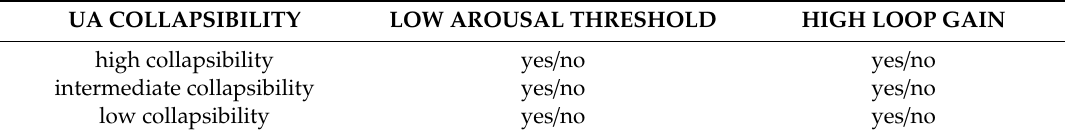
Table 4. The upper airway (UA) collapsibility, arousal threshold, and loop gain